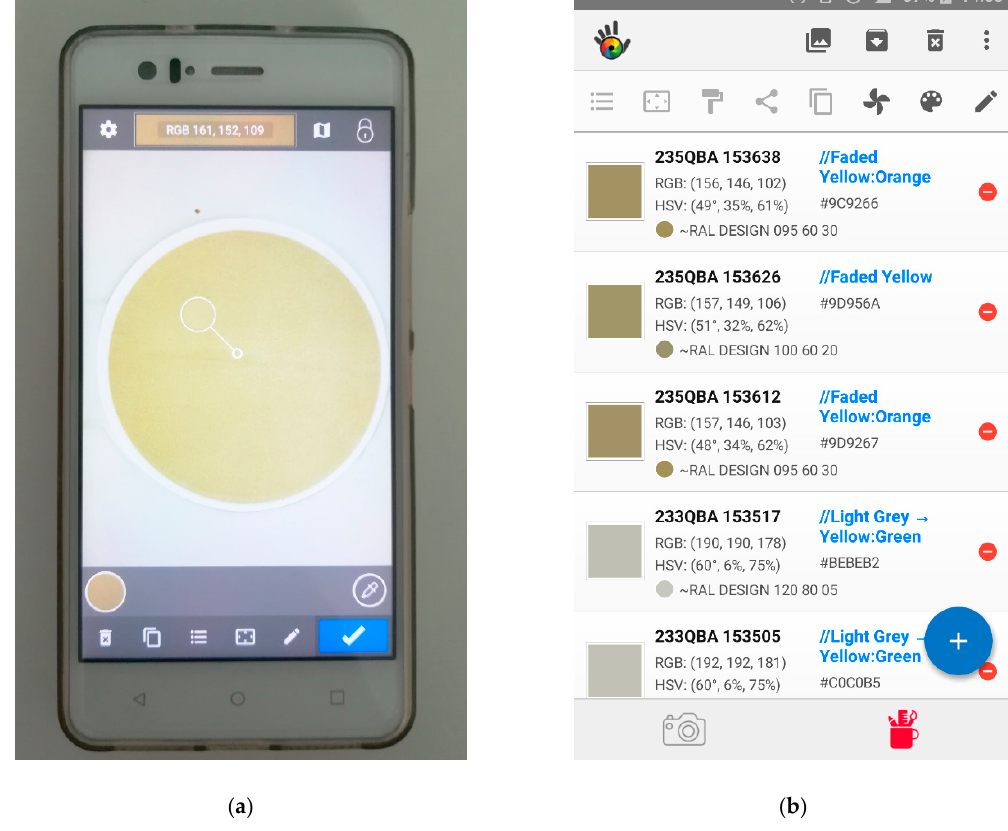
Figure 3. ( a ) Central region of image selected by the Color Grab app; ( b ) red, green, blue (RGB) and hue, saturation, value (HSV) information extracted from the Color Grab app.